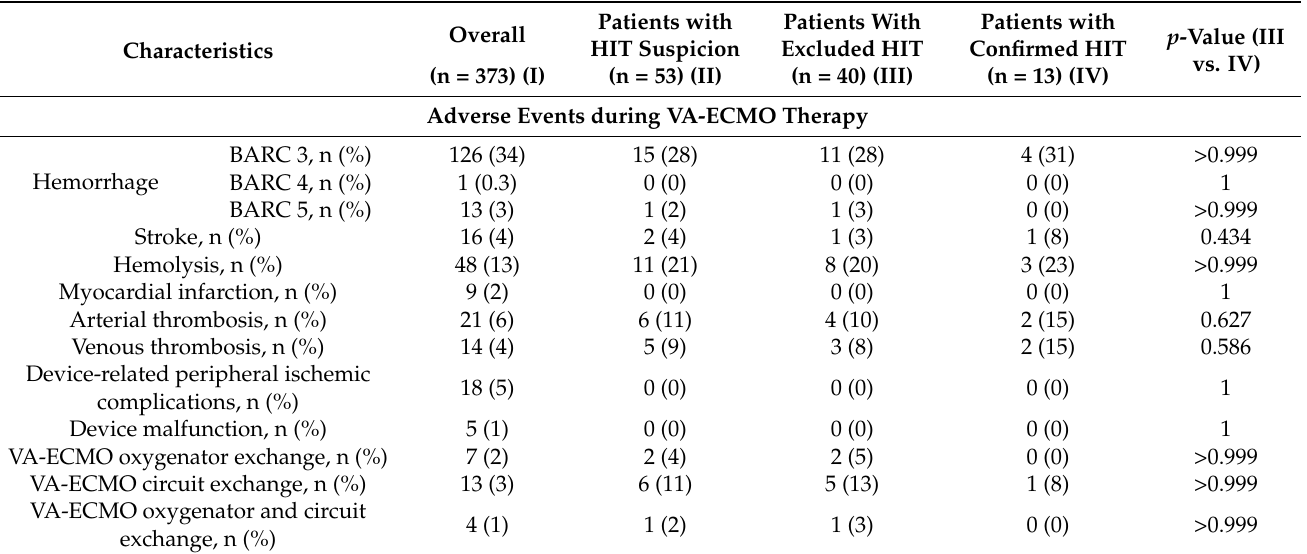
Table S3. Table 5. Adverse events during VA-ECMO